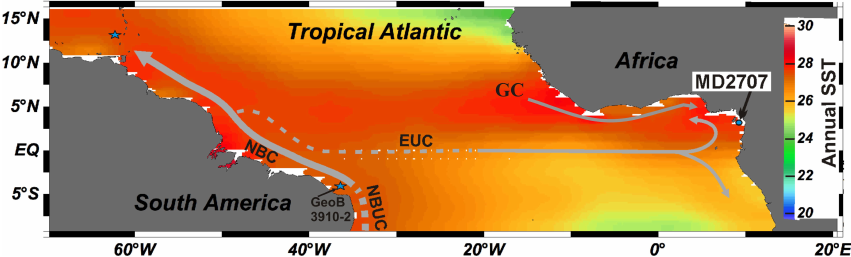
Fig. 1. MD03-2707 core location (blue dot) and annual SST in the tropical Atlantic (Locarnini et al., 2010). Solid and dashed lines indicate a highly simplified schematic of surface current (GC: Guinea Current; NBC: North Brazil Current) and subsurface current (EUC: Equatorial Undercurrent; NBUC: North Brazil Undercurrent) (Schott et al., 2002). Blue stars in the Caribbean Sea (H¨uls and Zahn, 2000) and western equatorial Atlantic (Jaeschke et al., 2007) indicate core locations discussed in the main text.